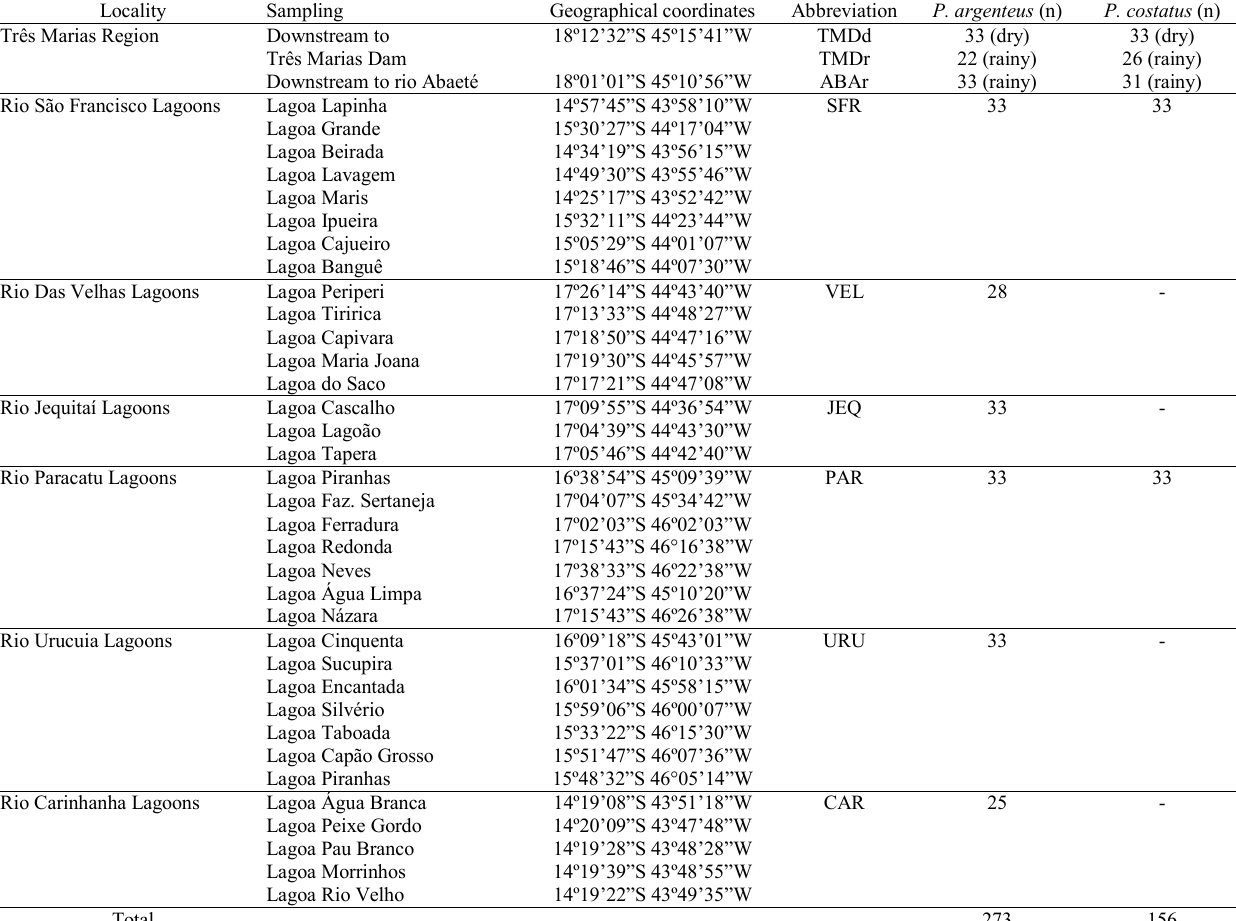
Table 1. Samples of Prochilodus argenteus and P. costatus from the rio São Francisco basin collected between July/2008 and July/2010. Samples from TMDr and ABAr were collected during the rainy season (November to February), and samples from TMDd were collected during the dry season (March to October). ABAr = rio Abaeté at rainy season; CAR = rio Carinhanha lagoons; JEQ = rio Jequitaí lagoons; PAR = rio Paracatu lagoons; SFR = rio São Francisco lagoons; URU = rio Urucuia lagoons; VEL = rio das Velhas lagoons; TMDd = Três Marias Dam at dry season; TMDr = Três Marias Dam at rainy